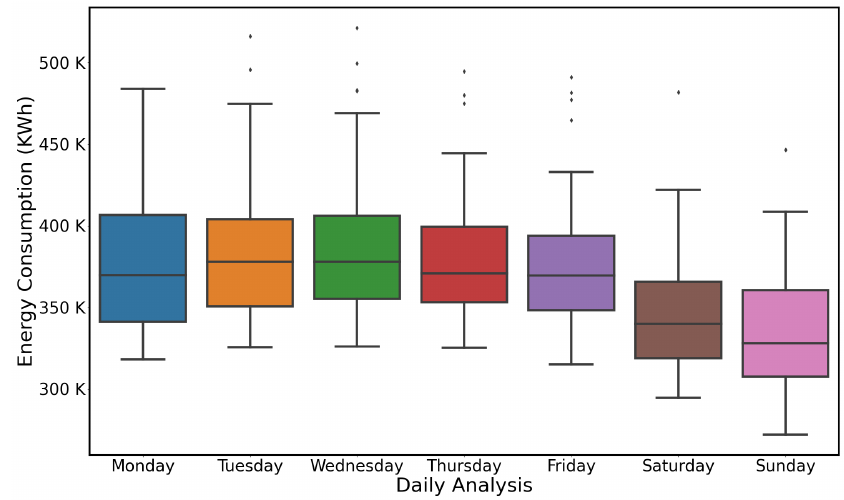
Figure 5. Daily analysis of electric consumption data.